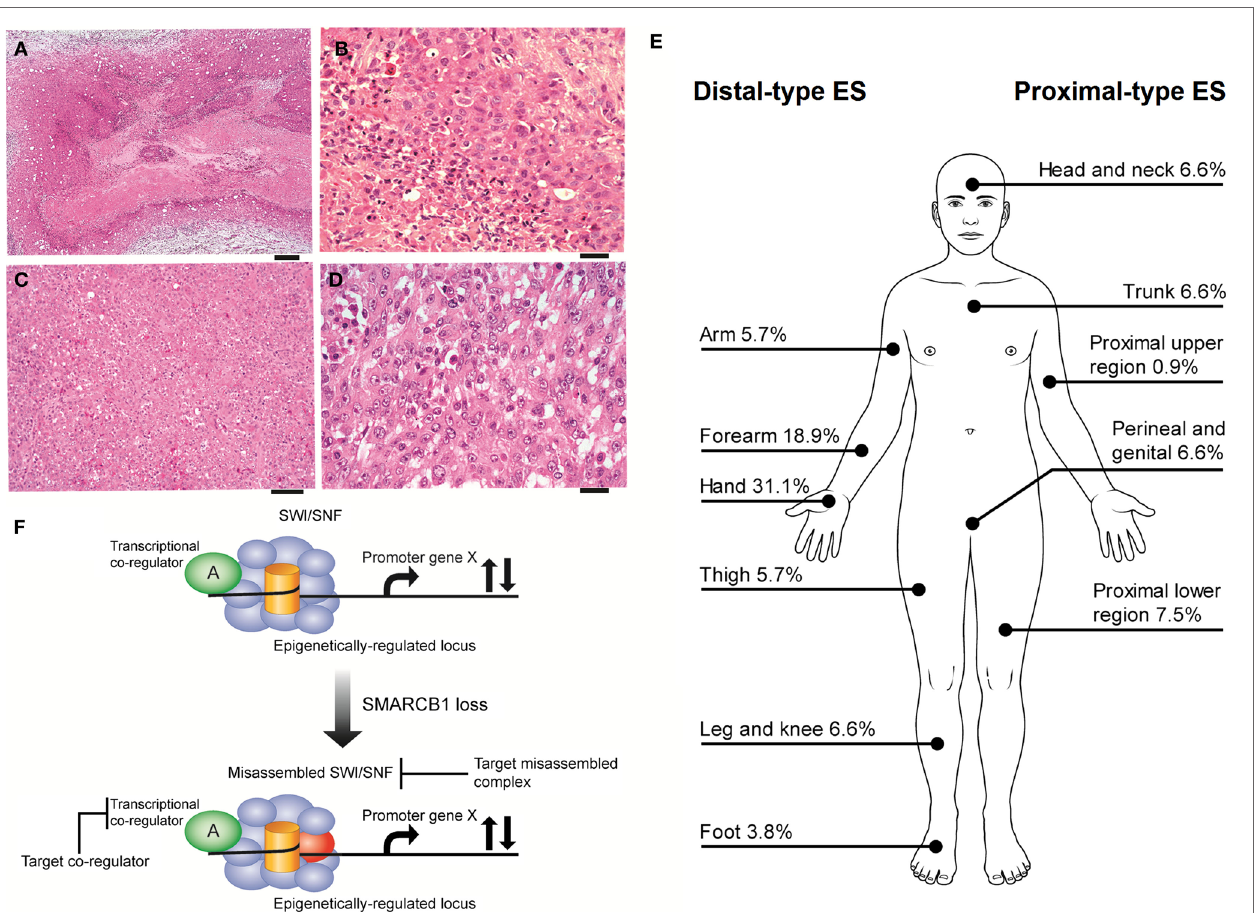
rhabdoid morphology, and which have ovoid vesicular nuclei, prominent large nucleoli, and relatively abundant eosinophilic cytoplasm. The cells are often more pleomorphic than those of the distal-type variant. On morphology alone, these cells are difficult to distinguish from other malignant epithelioid cells, such as those of carcinoma, melanoma, rhabdomyosarcoma, or epithelioid angiosarcoma, and therefore immunohistochemistry is crucial for establishing a correct diagnosis (hematoxylin and eosin, × 200). Scale bar, 50 μ M. (e) Distributions of ES subytpes, adapted from the largest series reported by